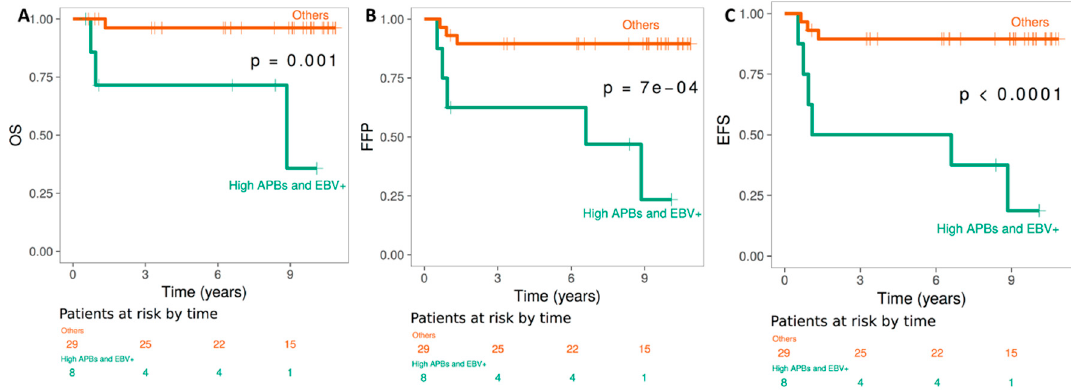
Figure 8. Analysis of the relationship between high expression of APBs in EBV+ HL patients and clinical outcome: ( A ) overall survival, ( B ) freedom from progression, and ( C ) event-free survival.